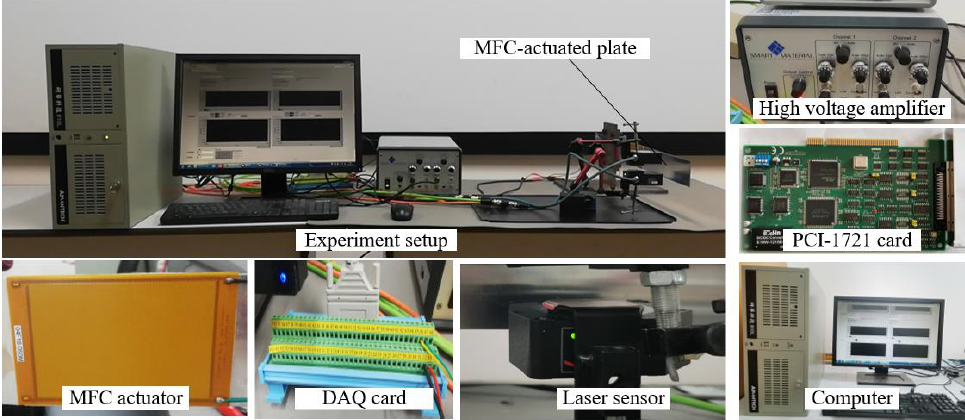
Figure 7. Experiment setup.